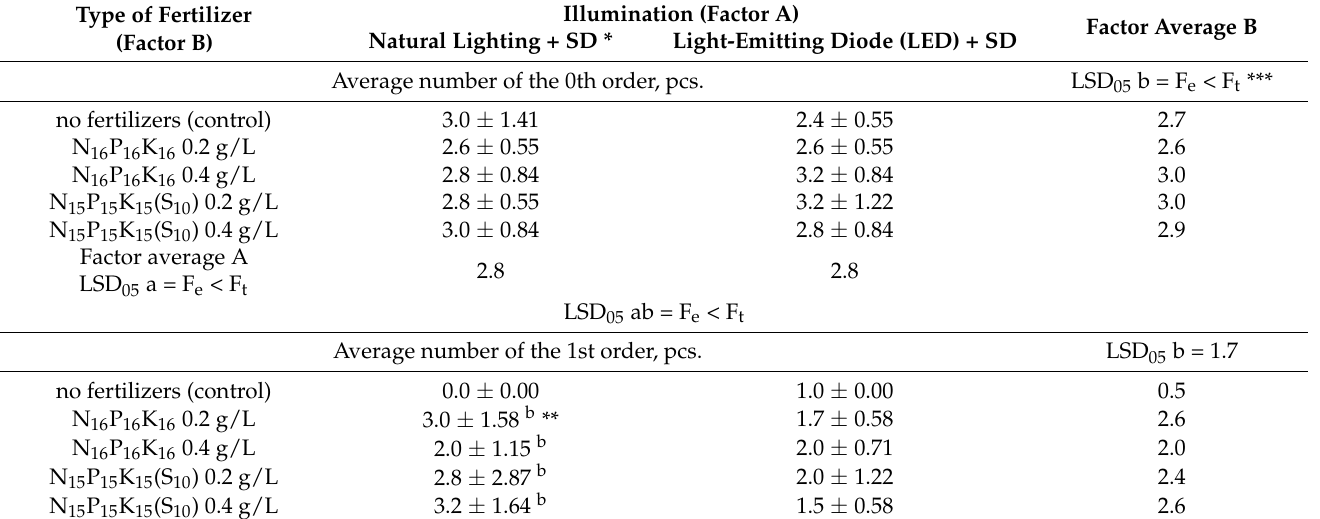
Table 2. Morphometric indicators of ex vitro development in highbush blueberry ( Vaccinium corymbo- sum L.) plants cv. Brigitta Blue on the 28th day of growing